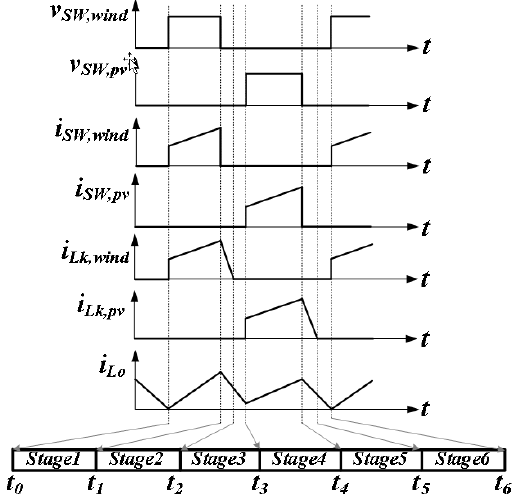
Figure 3. Conceptual key waveforms of the DIPWC.